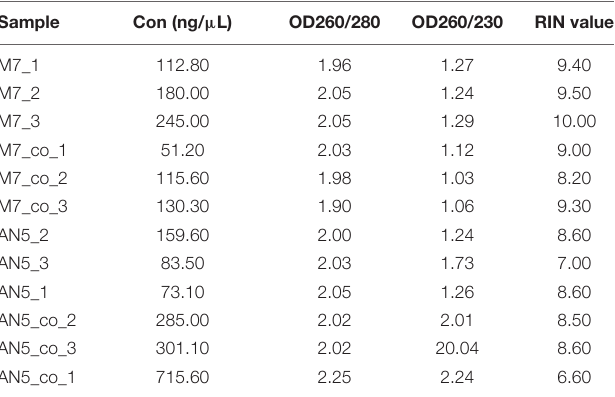
TABLE 2 | The quality results of the total RNA of 12